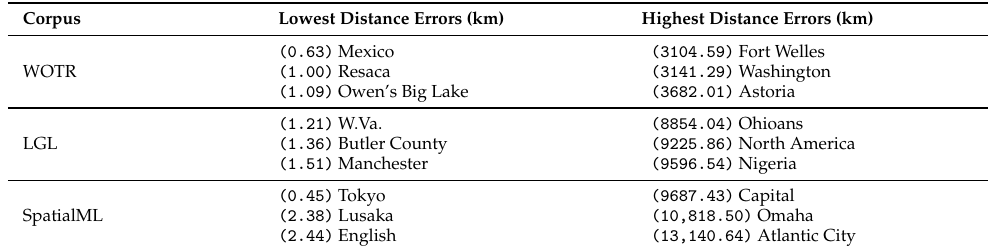
Table 4. Examples of toponyms, taken from the different corpora, with low/high prediction errors as assigned by the base model leveraging ELMo embeddings.